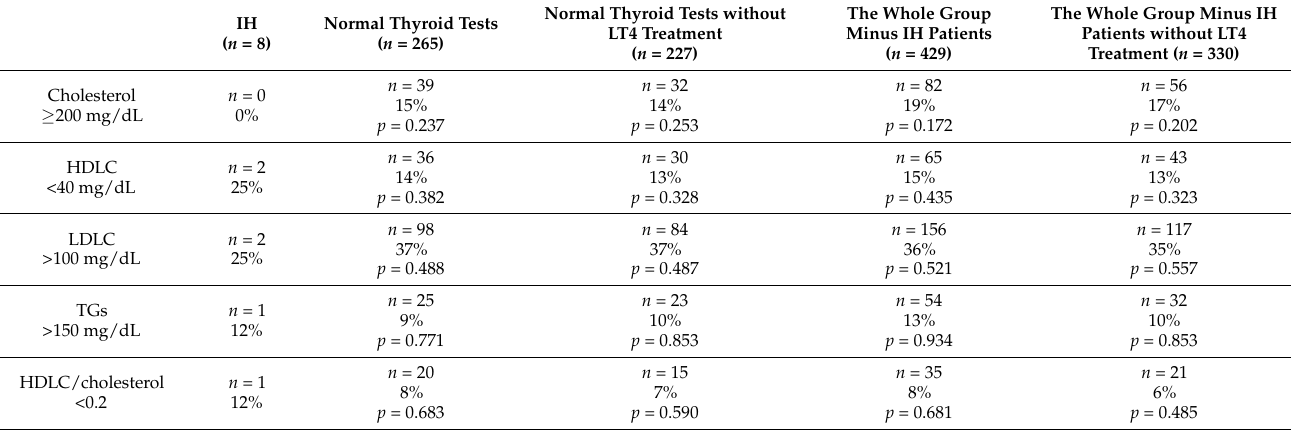
Table 3. Percentage of abnormal lipid profile in patients with isolated hypothyroxinemia (IH) vs. patients with normal thyroid tests (additionally after excluding individuals on L-thyroxine (LT4) treatment) and vs. the whole group of 466 inpatients minus patients with IH (additionally after excluding individuals on L-thyroxine (LT4) treatment).